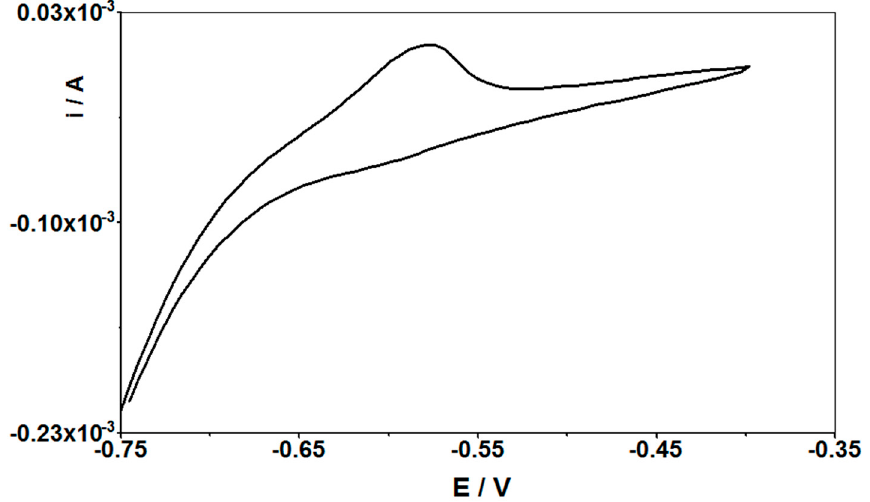
Figure 10. Cyclic voltammograms of 5 × 10 − 8 M Cd(II) in 0.1 M HCl and 2 × 10 − 4 M Cu(II) solution at the CuF/CN/SPE electrode, for scan rate of 1 V s − 1 .